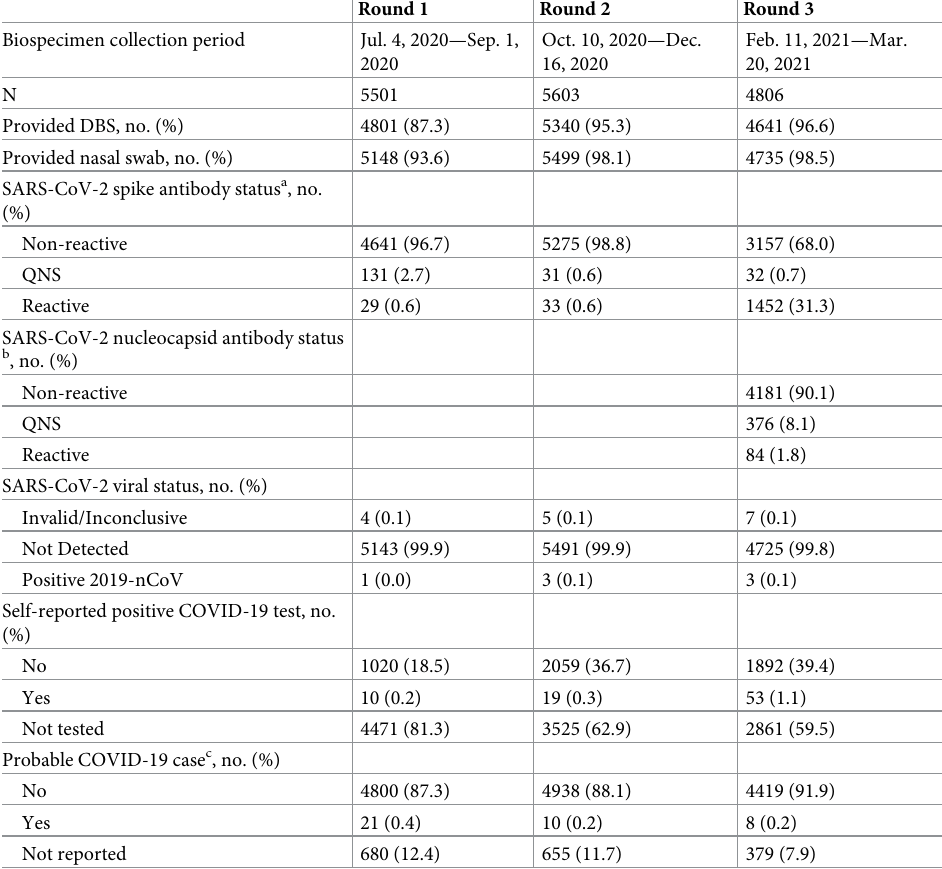
Table 2. Prevalence of SARS-CoV-2 related outcomes among participants per study round. Round 1 Round 2 Round